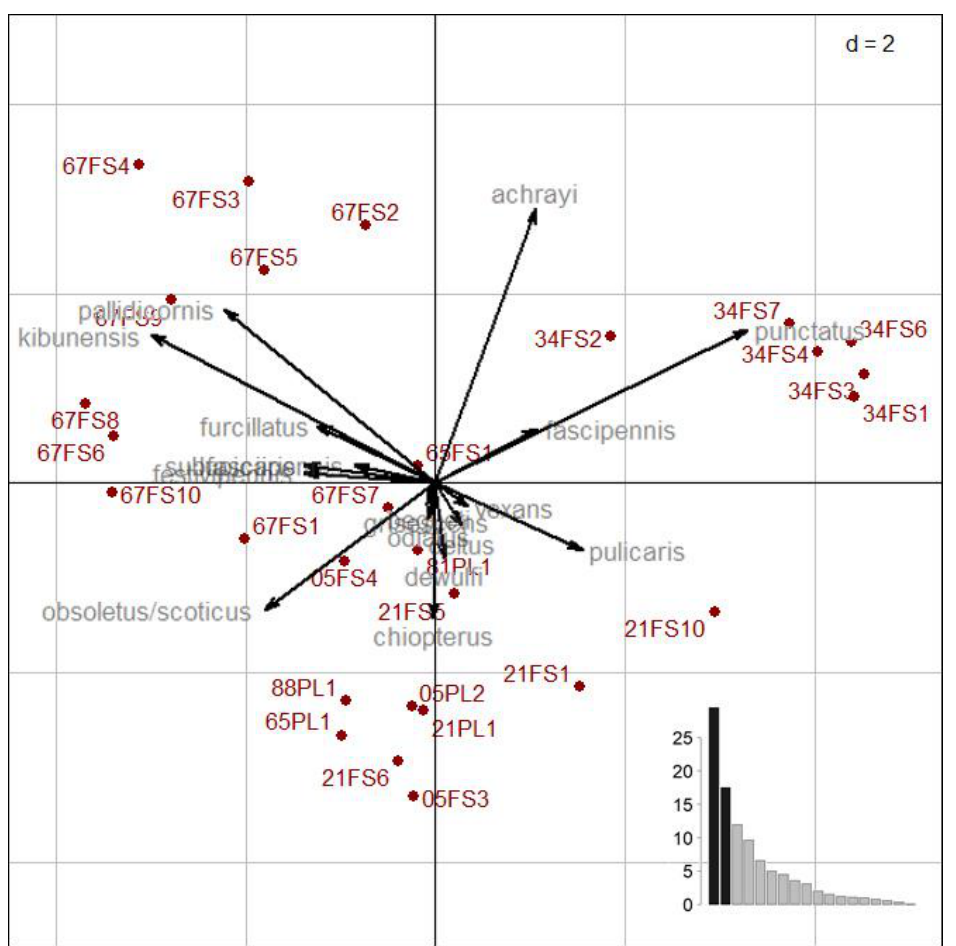
Figure 4. Scatter plot (two first axes) of the principal component analysis (dudi.pca function) performed on the proportion of Culicoides per species and site transformed as ordinal classes (encoded 0 as absent, 1 as very rare (0 – 2%), 2 as rare (2 – 5%), 3 as secondary (5 – 20%), 4 as co-dominant (20 – 60%), and 5 as dominant (>60%)). The drivers of the global species community structure were first the habitat characteristics, which explained 37% of the PCA inertia ( p = 0.001 using a permutation test), then the eco-climatic zones and the altitude, which were intertwined and explained respectively 35% and 32% of the PCA inertia ( p = 0.001), respectively, and finally the host characteristics with 13% ( p = 0.035) and the survey location with 8% ( p = 0.022).